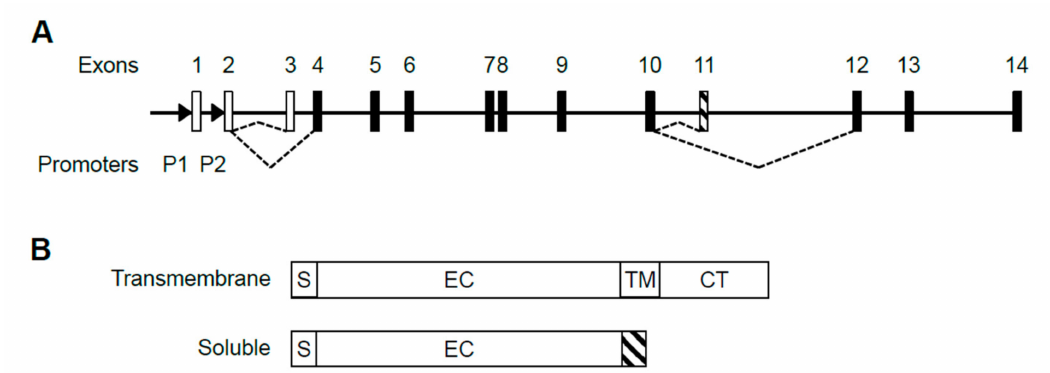
Figure 1. Structure of the human IL5RA gene, its alternative transcripts and protein isoforms. ( A ) Alternative splicing choice resulting in the soluble or transmembrane splice variant is indicated by dashed lines. Open boxes represent untranslated exons and black boxes represent translated exons. Exon 11 (striped) is soluble-specific while exons 12–14 are transmembrane- specific. Promoters P1 and P2 are located upstream of exons 1 and 2 as indicated by arrowheads. ( B ) IL-5R α exists in two protein isoforms. The soluble isoform lacks transmembrane and cytoplasmic domains and instead has a soluble isoform-specific domain (striped) encoded by exon 11. S : signal peptide. EC : extracellular domain; TM : transmembrane domain; CT : cytoplasmic